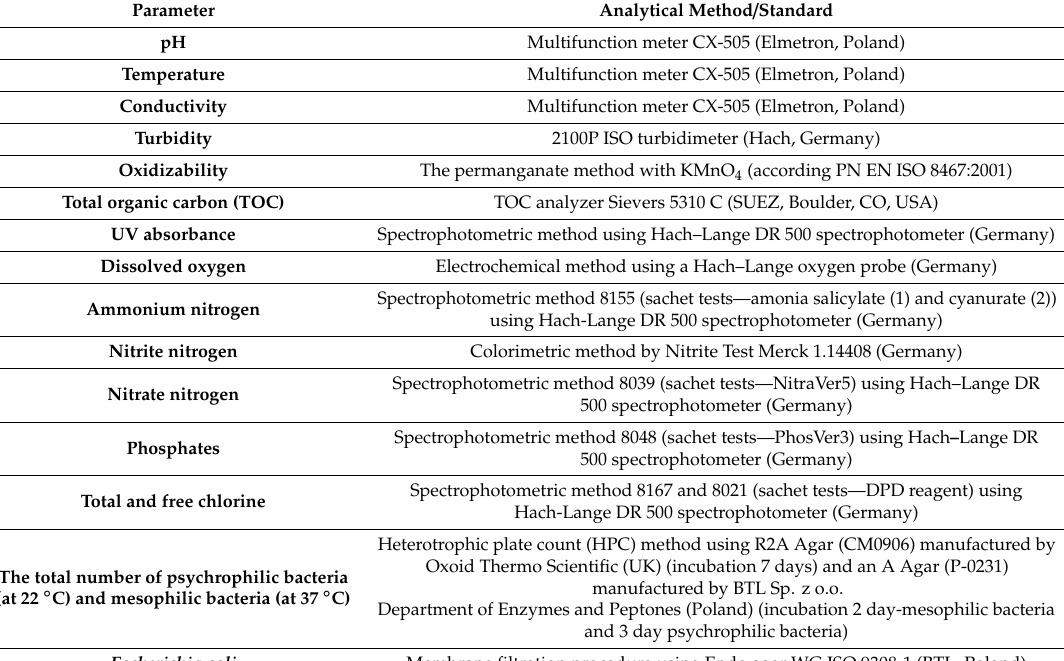
Figure 3. Water treatment technology. Table 1. Analytical methods and standards used in experiment.